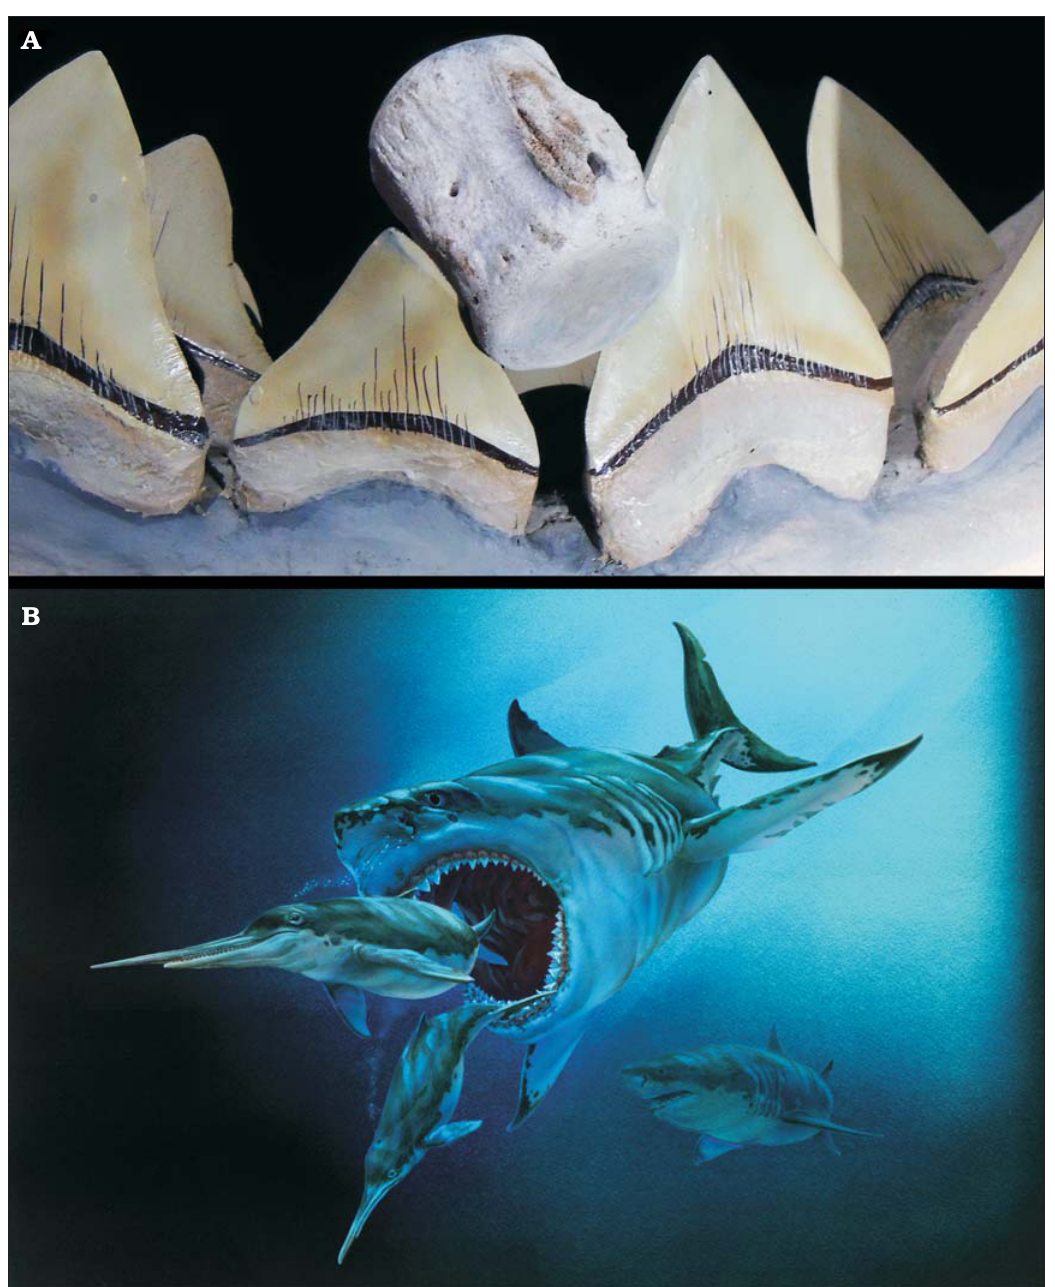
Fig. 5. A . CMM-V-4360 placed between two adjacent teeth in the reconstructed jaw of Carcharocles megalodon at the Calvert Marine Museum, Solo- mons, Maryland, USA. B . Life restoration of C. megalodon pursuing two eurhinodelphinids. Rendering by artist Tim Scheirer